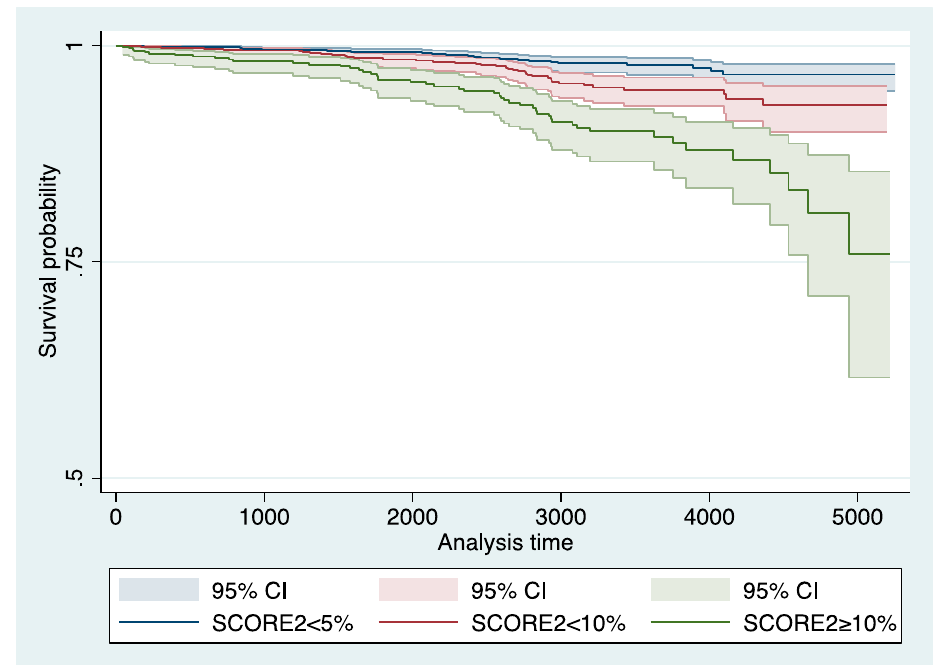
Figure 5. Survival data for all-cause mortality in the three SCORE2 strata. The all-cause mortality was 7% over a median follow-up of 2768 days. In the Cox regression model, SCORE2 was associated with all-cause (HR 1.11 95%CI 1.09–1.14; p < 0.001) mortality. Abbreviations: CI: confidence interval; and HR: hazard ratio.